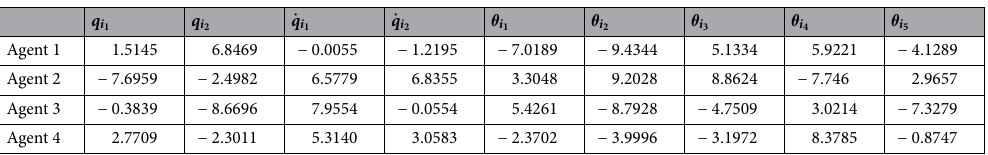
Table 1. The initial values of the four robotic agents for dynamic coordinated